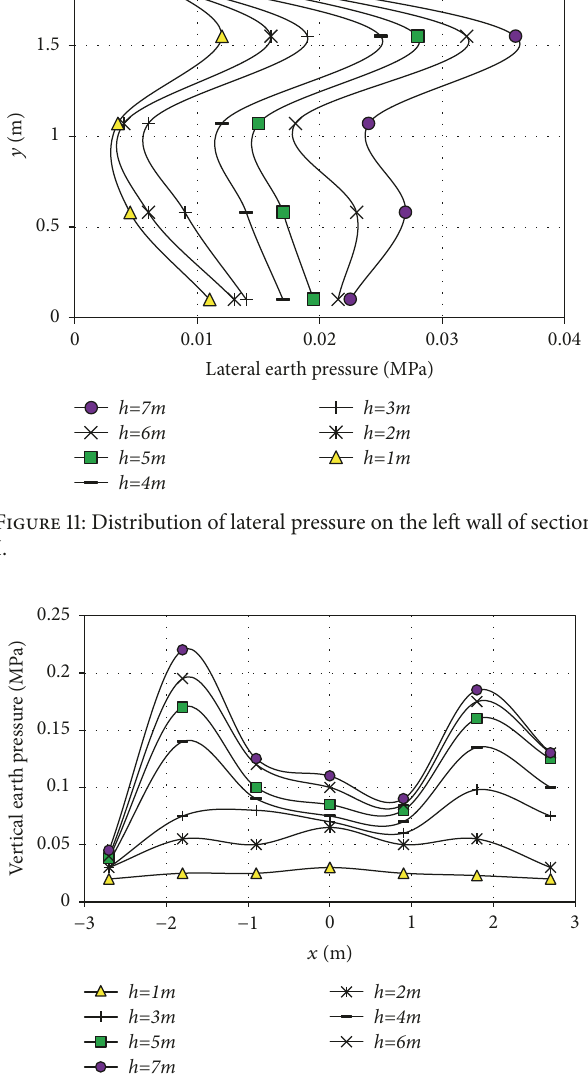
Figure 12: Distribution of vertical pressure on the left wall of section I.